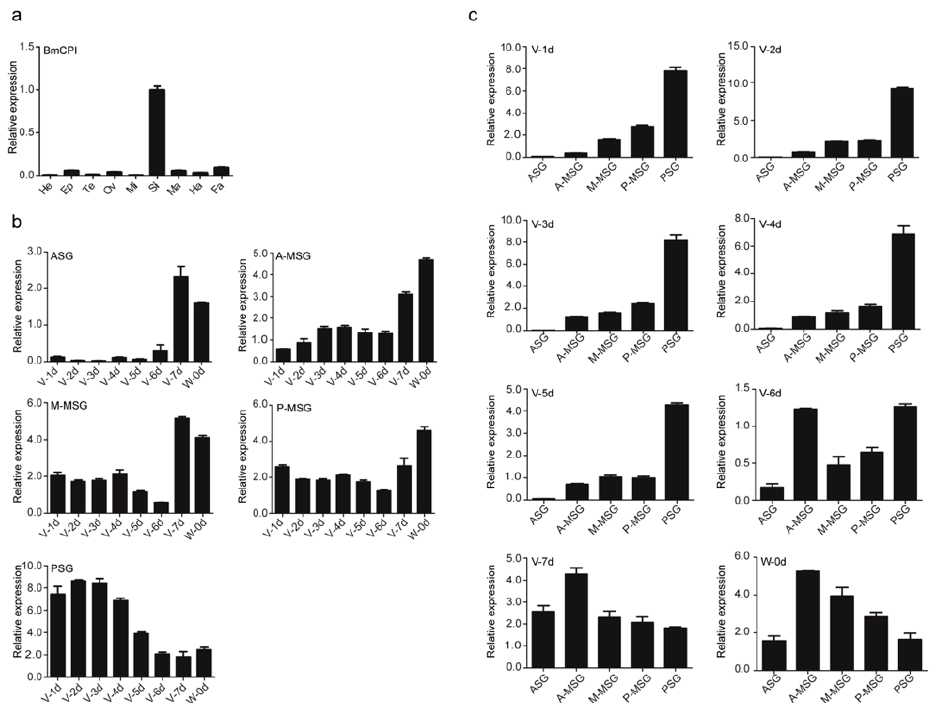
Figure 1. The expression and activity evaluation of recombinant silkworm carboxypeptidase inhib- itor. ( a ) Prokaryotic expression, isolation, and purification of silkworm carboxypeptidase inhibitor protein. ( b ) Determination of the inhibitory activity of recombinant silkworm carboxypeptidase in- hibitor. ( c ) Thermostability assay of recombinant silkworm carboxypeptidase inhibitors. ( d ) Acid– base stability assay of the recombinant silkworm carboxypeptidase inhibitor. PC means positive control potato carboxypeptidase inhibitor; NC means negative control PBS. The differences between the experimental and the control groups were analyzed by the Student’s t test, *** p < 0.001.